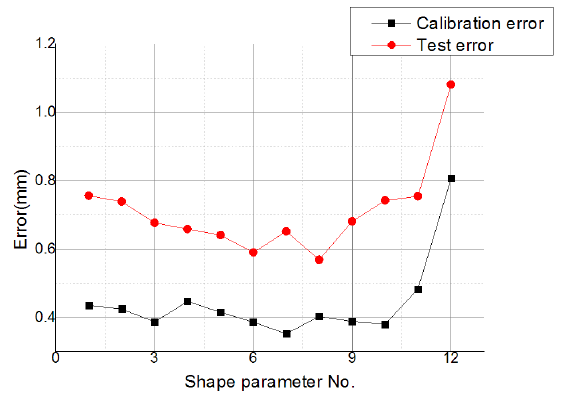
Figure 11. Calibration error and test error with different values of the shape parameter. Table 2. Fitting error with different values of the shape parameter. Calibration Data Set Test Data No.